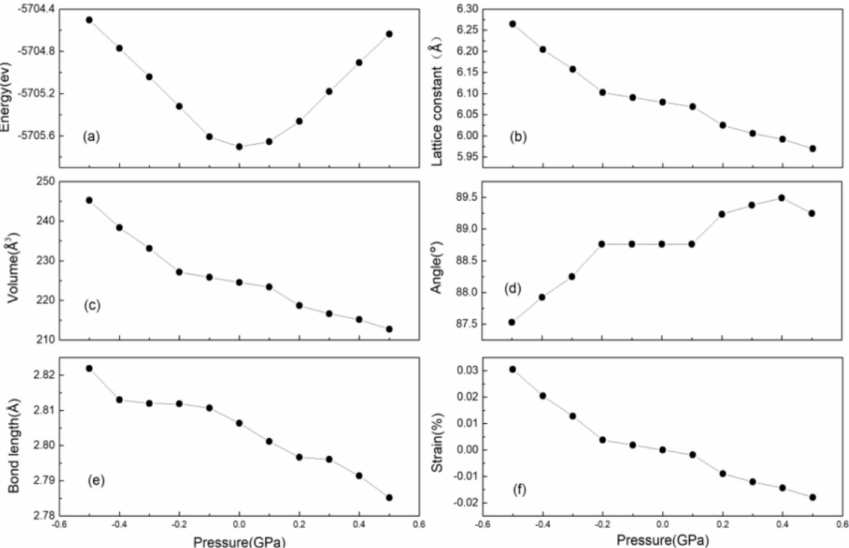
Figure 2. The structure parameters of CsGeI 3 under different pressure conditions. ( a ) The curve of energy. ( b ) The curve of the lattice constant. ( c ) The curve of volume. ( d ) The curve of cell angle. ( e ) The curve of bond length of Ge-I. ( f ) The curve of the